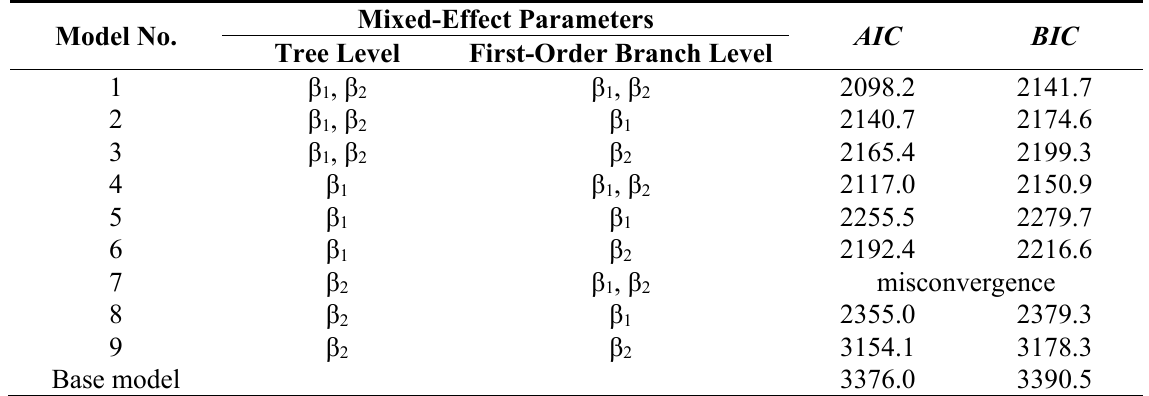
Table 4. Values of AIC and BIC of mixed-effect models and the base model for the second-order branches. Model